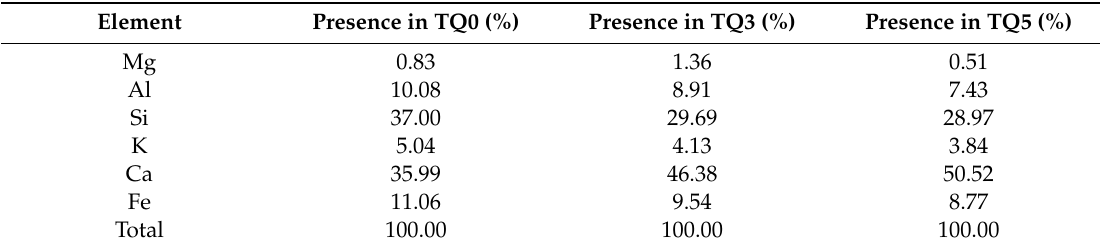
Table 4. TQ0, TQ3, and TQ5 28 d microanalysis.